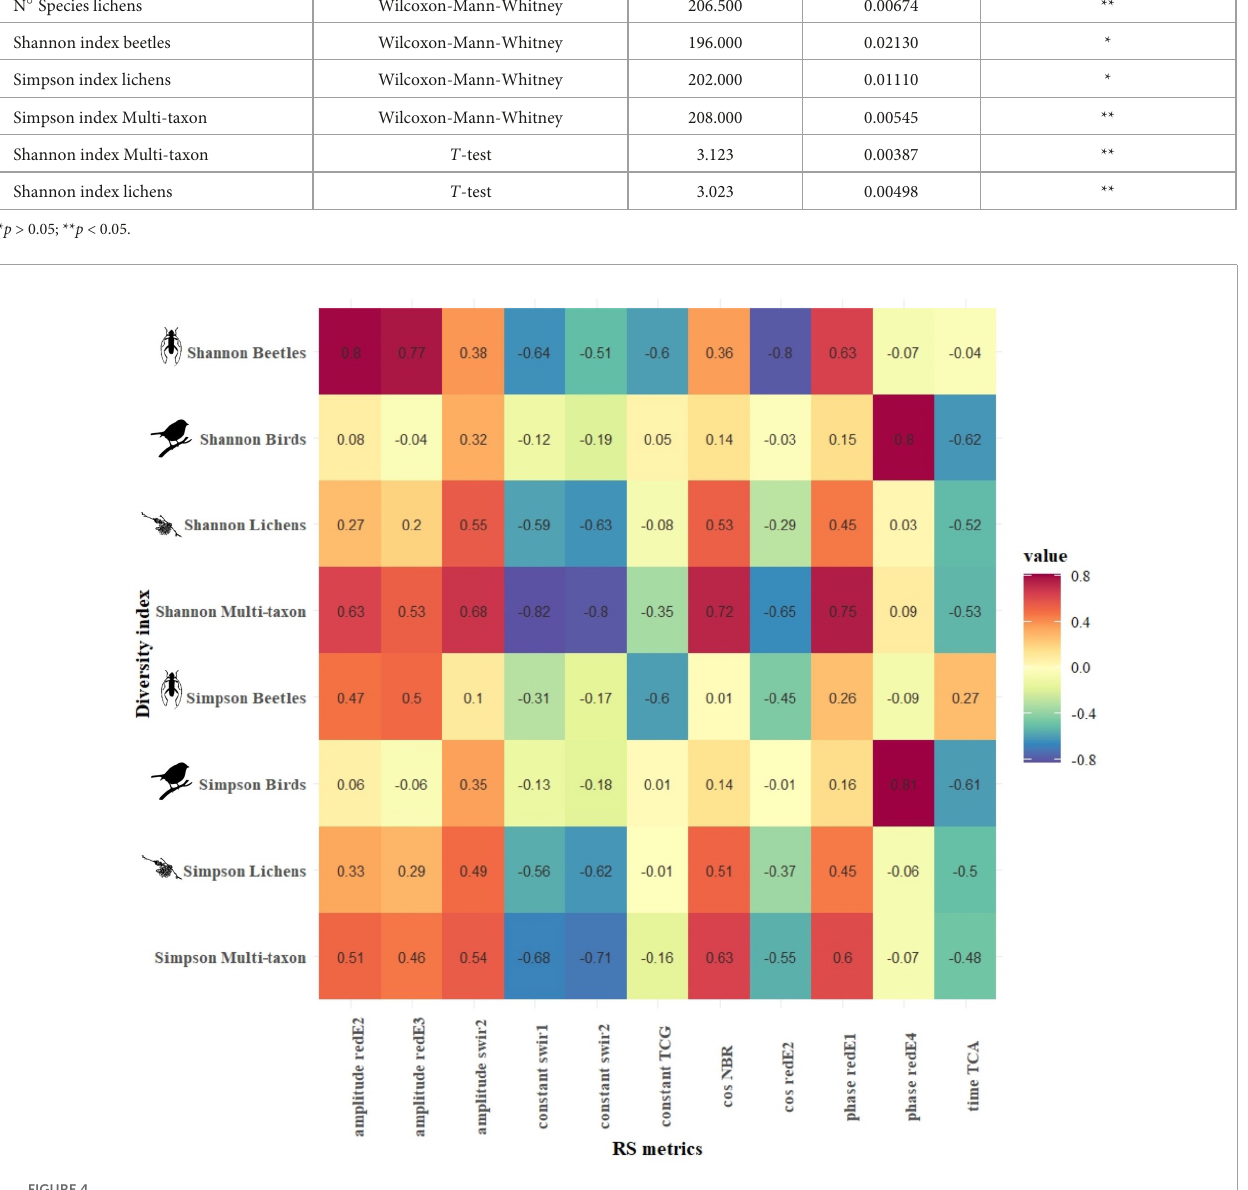
Frontiers in Forests and Global